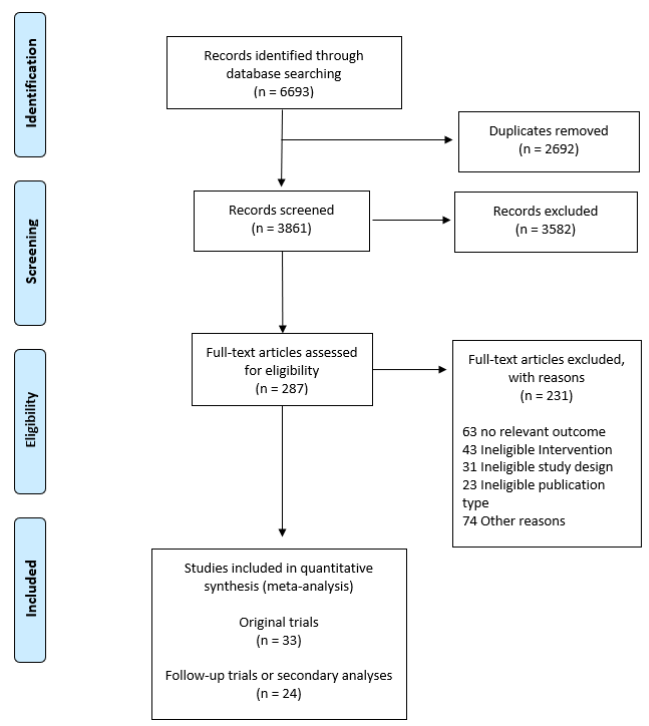
Figure 1. Flow diagram of literature and study selection process according to the 2009 Preferred Reporting Items of Systematic reviews and Meta-Analyses (PRISMA) with modification. Follow-up trials or secondary analyses represent reports involving the same study population for the same intervention